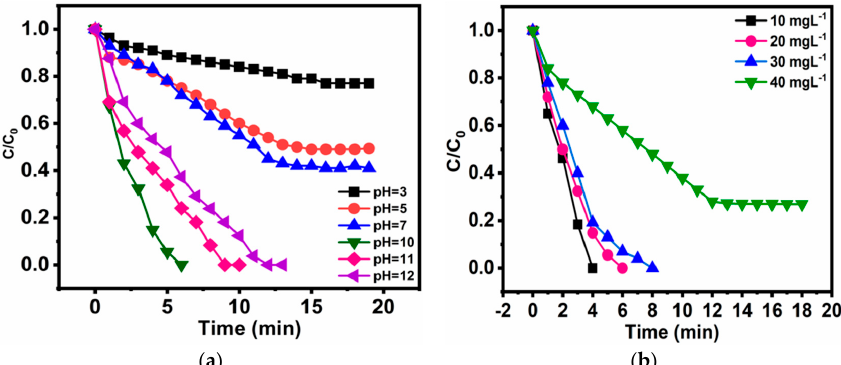
Figure 4. ( a ) C/C 0 versus time curve for the degradation of RhB with different concentration dye in Figure 4. ( a ) C / C 0 versus time curve for the degradation of RhB with di ff erent concentration dye in the the presence of AC-700 and ( b ) C/C 0 versus time curve for the degradation of RhB at different pH. presence of AC-700 and ( b ) C / C 0 versus time curve for the degradation of RhB at di ff erent